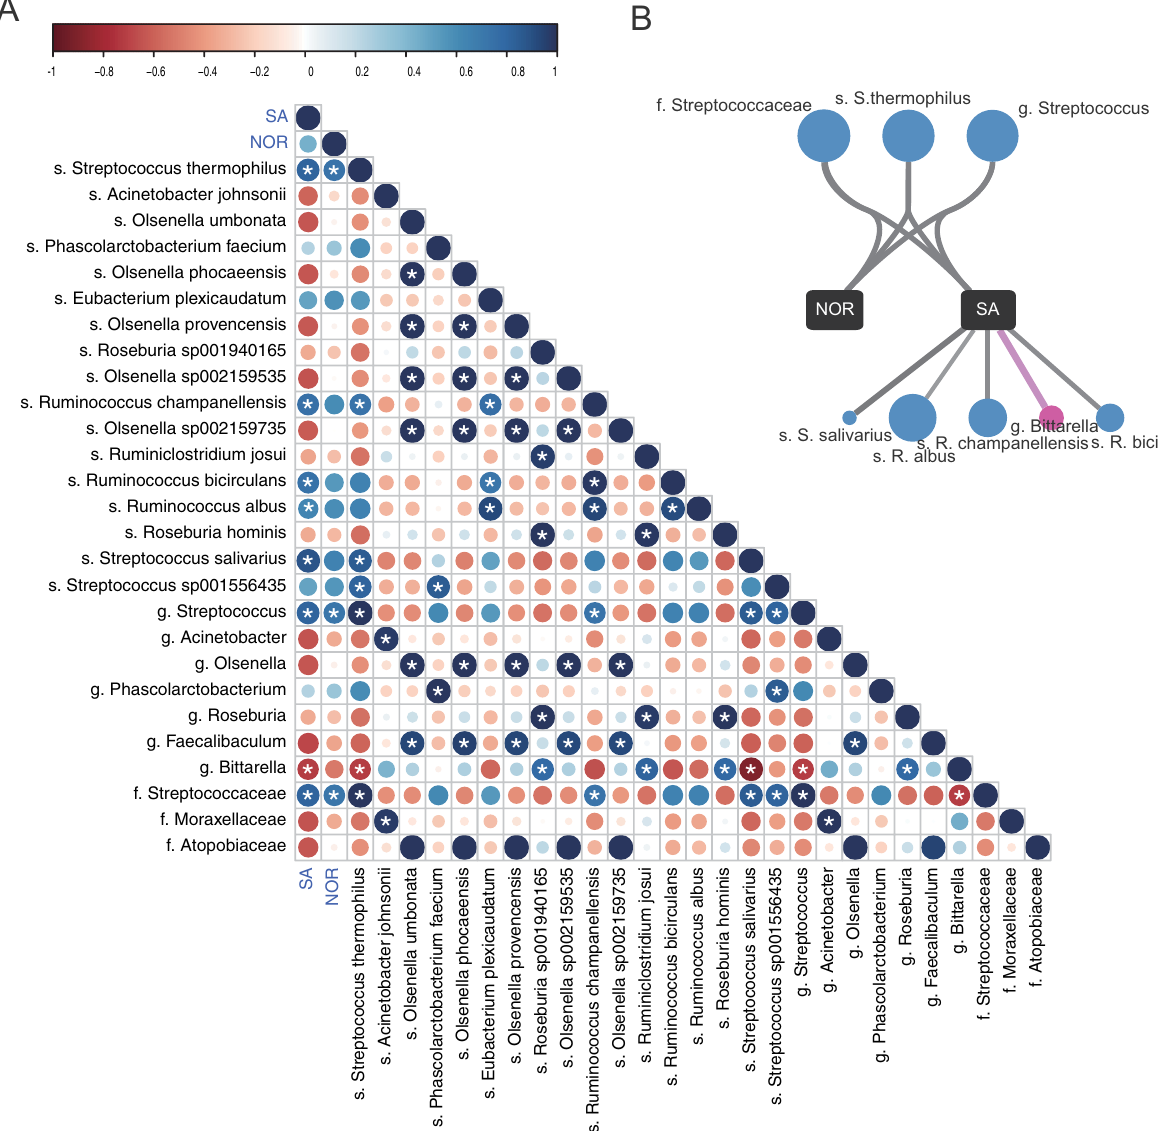
Figure 5. Relationship between altered gut microbiota and cognition traits. ( A ) Correlation between gut microbiota significantly modulated by EG007 consumption and cognition traits (SA and NOR). Strong correlations are represented as large circles, and weak correlations are represented as small circles. The colors of the scale bar indicate the correlation coefficient with dark blue indicating perfect positive correlation (correlation coefficient = 1) and dark red indicating the perfect negative correlation (correlation coefficient = − 1). Statistical significance was defined as P -value < 0.05 (indicated with *). ( B ) Networks between the cognition traits and the significantly modulated gut microbiota which are highly correlated with the traits. Circle nodes represent taxonomic units, and rectangle nodes represent cognition traits. The sizes of circle nodes indicate the relative abundance in the EG007-treated mice gut, and the color of circle nodes represent increased (blue) and decreased (pink) after EG007 consumption. The lines represent the degree of correlation (width) and positive (grey) or negative (pink)